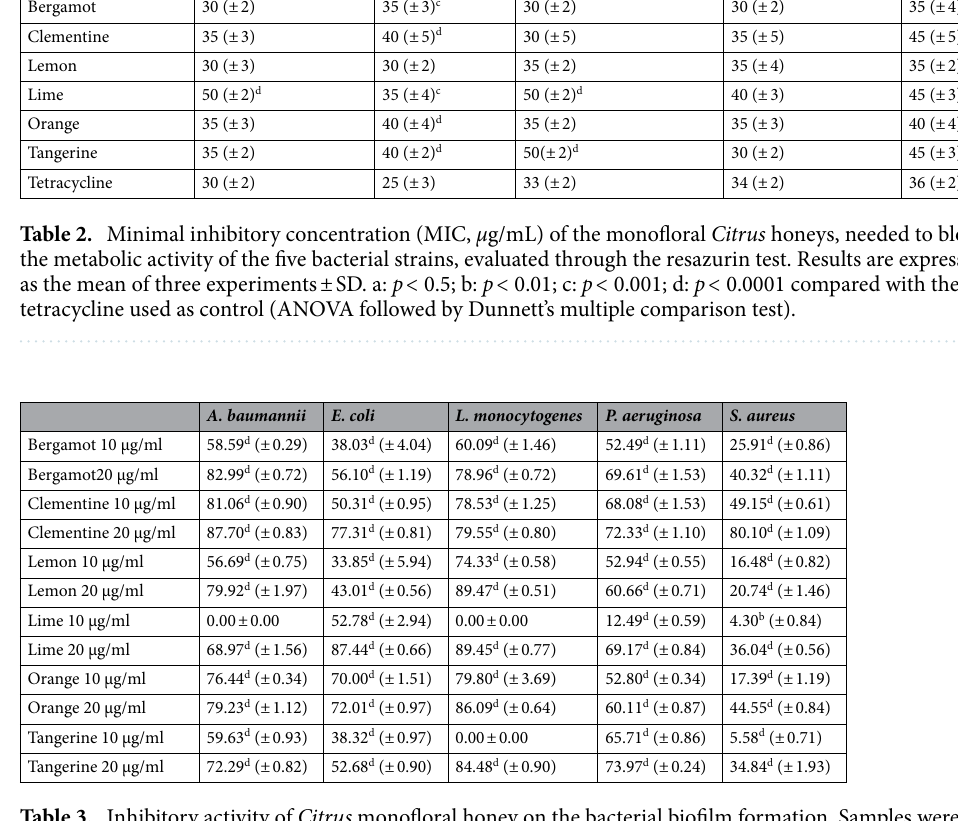
Table 3. Inhibitory activity of Citrus monofloral honey on the bacterial biofilm formation. Samples were tested at two concentrations, 10 µg/ml and 20 µg/ml against pathogens A. baumannii , E. coli , L. monocytogenes , P. aeruginosa , and S. aureus following the method described in the section of material and methods. The percentages of inhibition were calculated assuming for the control (untreated bacteria) an inhibition = 0. Results are expressed as the mean of three experiments (± SD). a: p < 0.5; b: p < 0.01; c: p < 0.001; d: p < 0.0001 (ANOVA followed by Dunnett’s multiple comparison test).